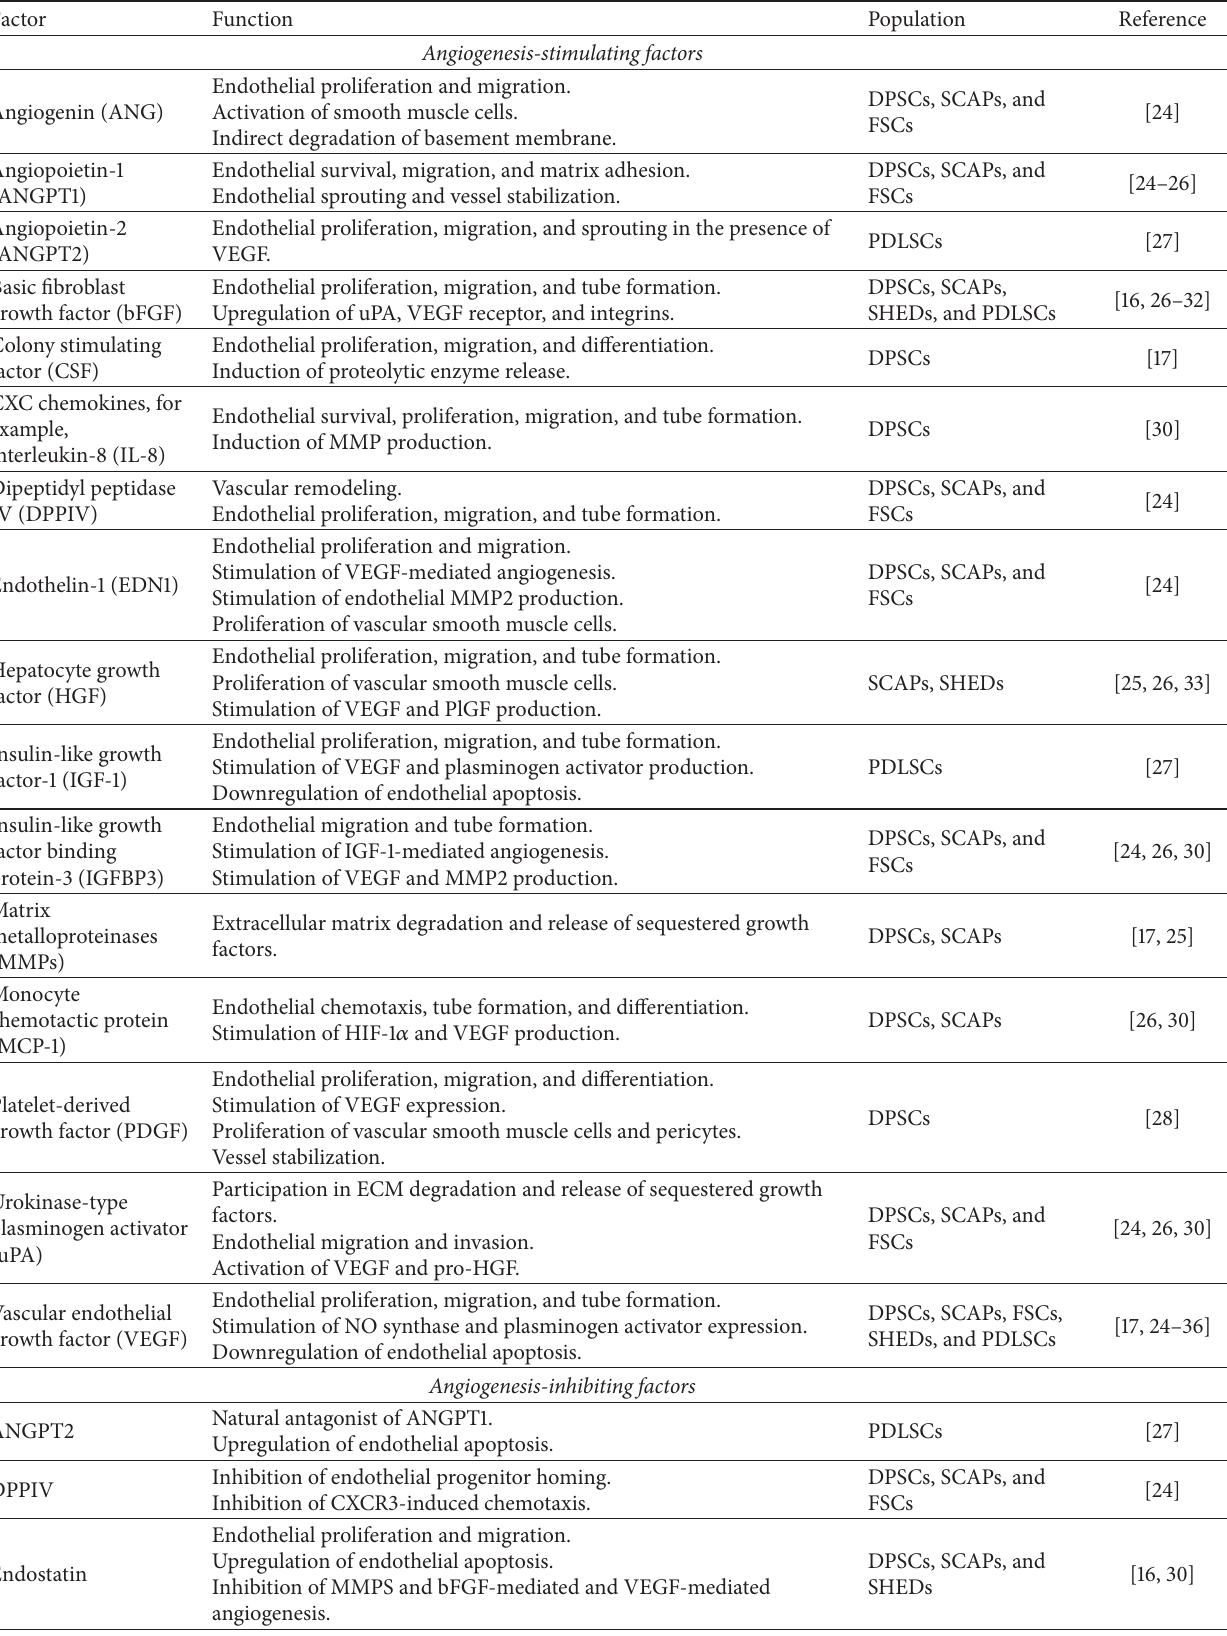
Table 1: The secretome of dental stem cells and its associated